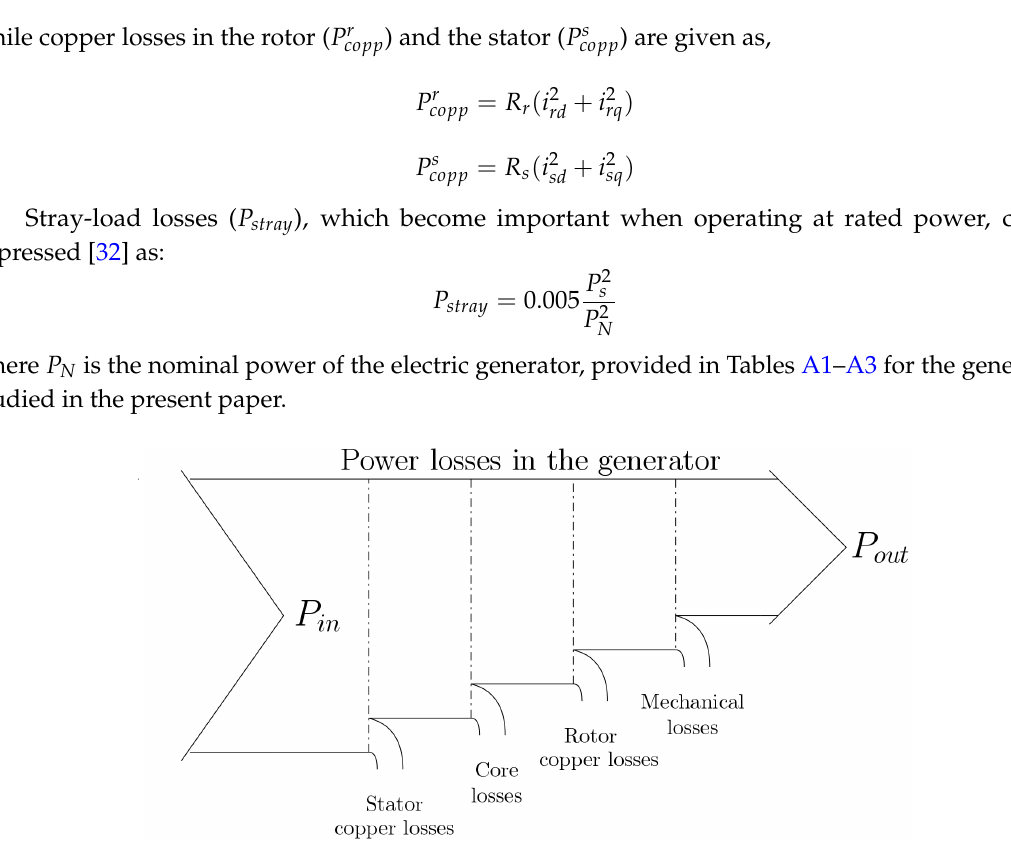
Figure 5. Specific power losses in an electric